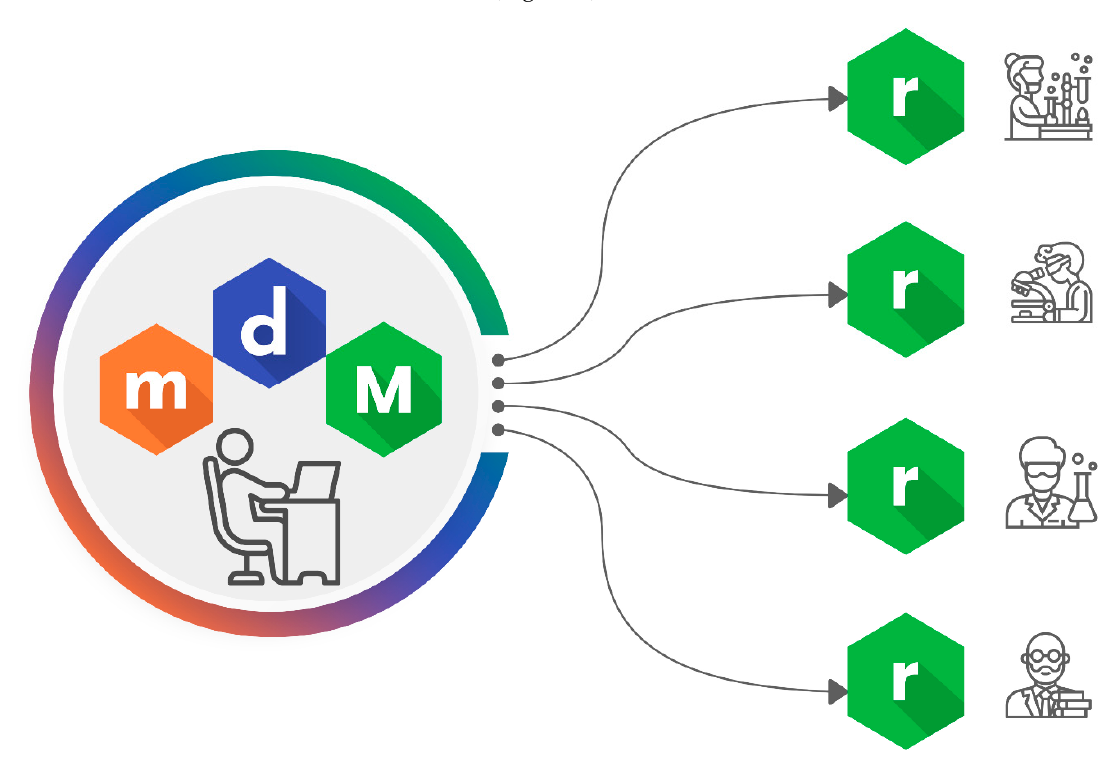
Figure 6. Once generated, models can be deployed as alvaRunner projects. Colleagues and other researchers can make predictions on their molecules using only alvaRunner.